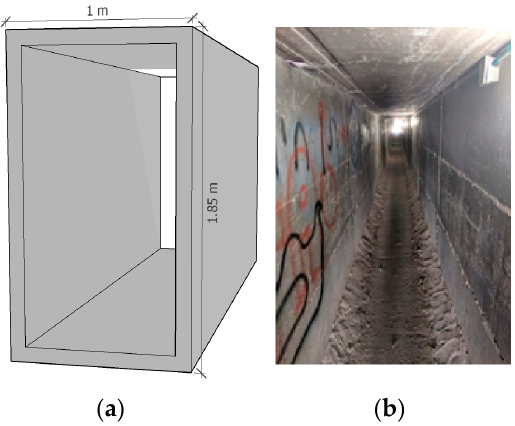
Figure 2. Straight tunnel with concrete walls of rectangular profile with a height of 1.85 m, width of 1 m ( a ) a schema, and ( b ) a real tunnel.